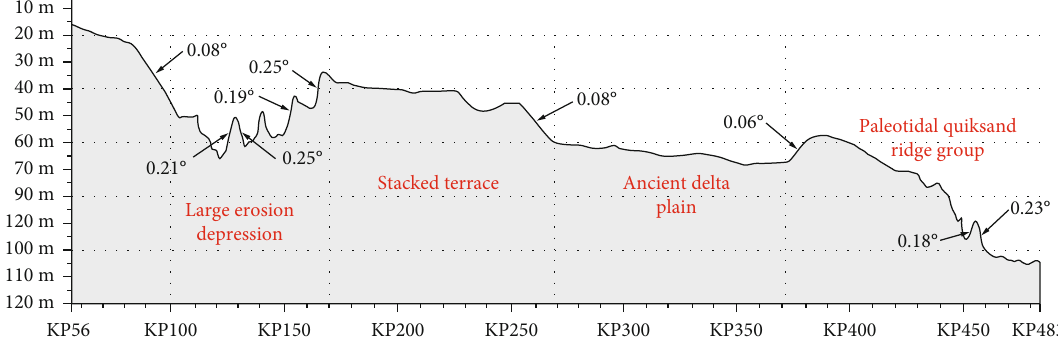
Figure 5: KP56km ~ KP484km topographic pro fi le.